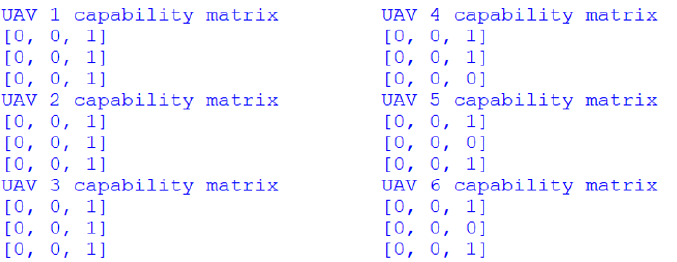
Figure 16. Initialized capability matrixes of all six UAVs.